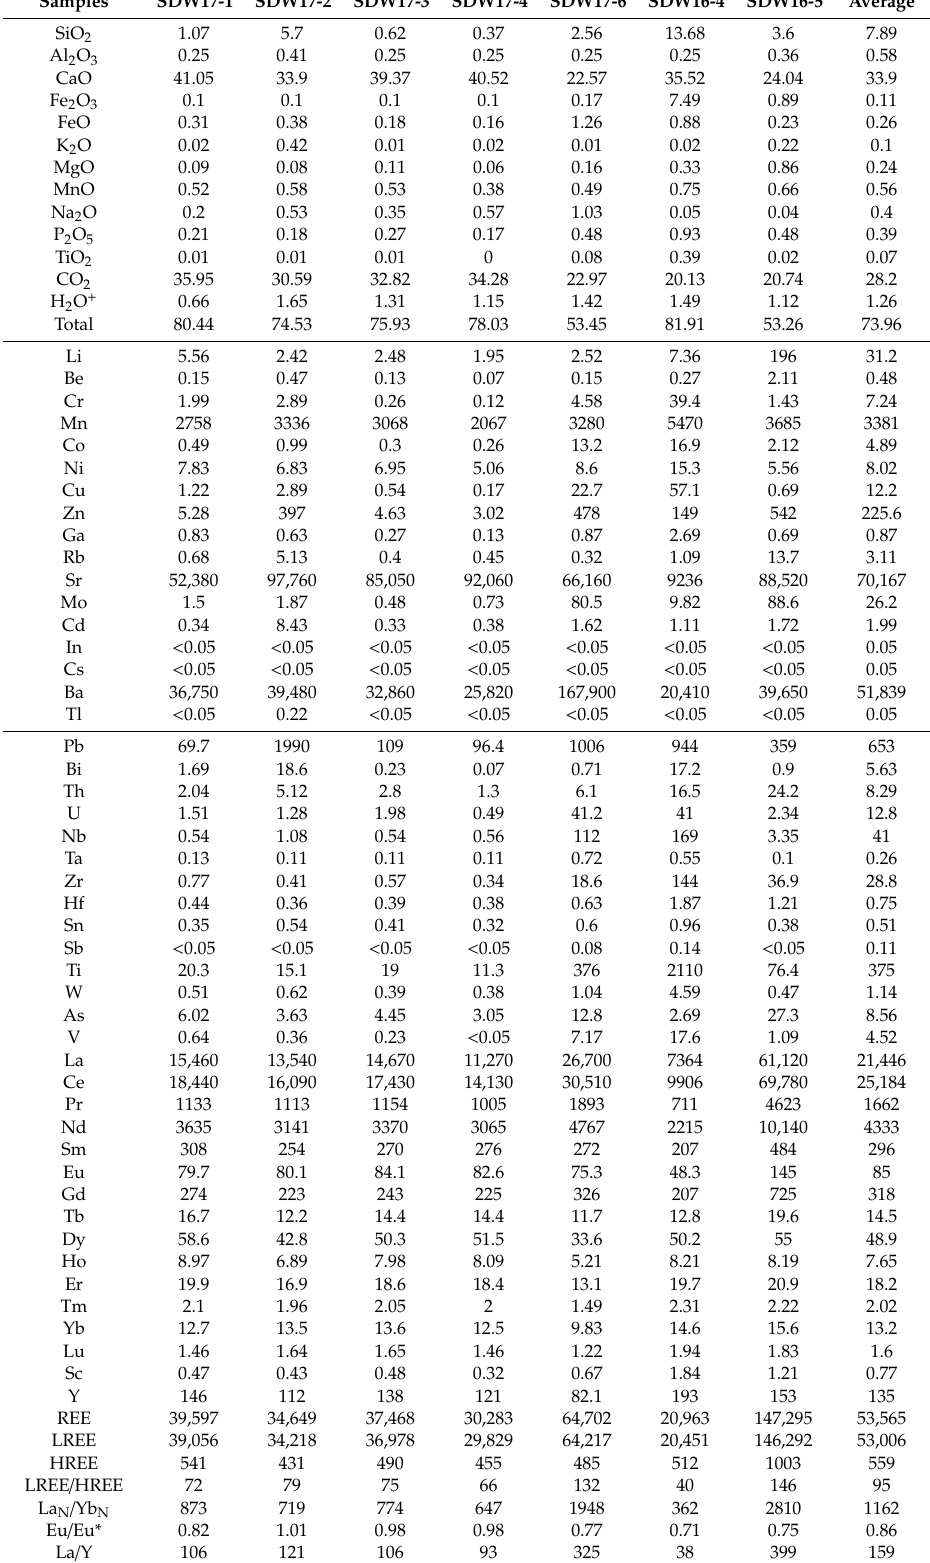
Table 7. Whole-rock geochemical compositions of typical REE ores in the Weishan deposit.